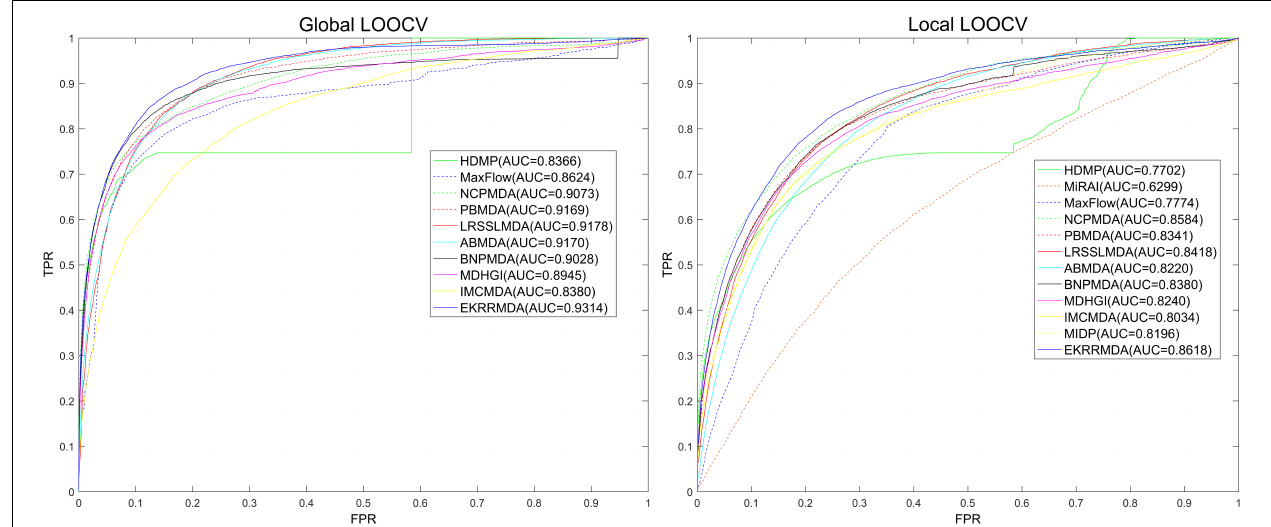
FIGURE 3 | Performance comparisons between EKRRMDA and other 11 prediction models (HDMP, MiRAI, MaxFlow, NCPMDA, PBMDA, LRSSLMDA, ABMDA, BNPMDA, MDHGI, IMCMDA, and MIDP) in terms of ROC curve and AUC based on local and global LOOCV, respectively. As a result, EKRRMDA obtained AUCs of 0.9314 and 0.8618 in the global and local LOOCV, which exceed all the previous classical models.